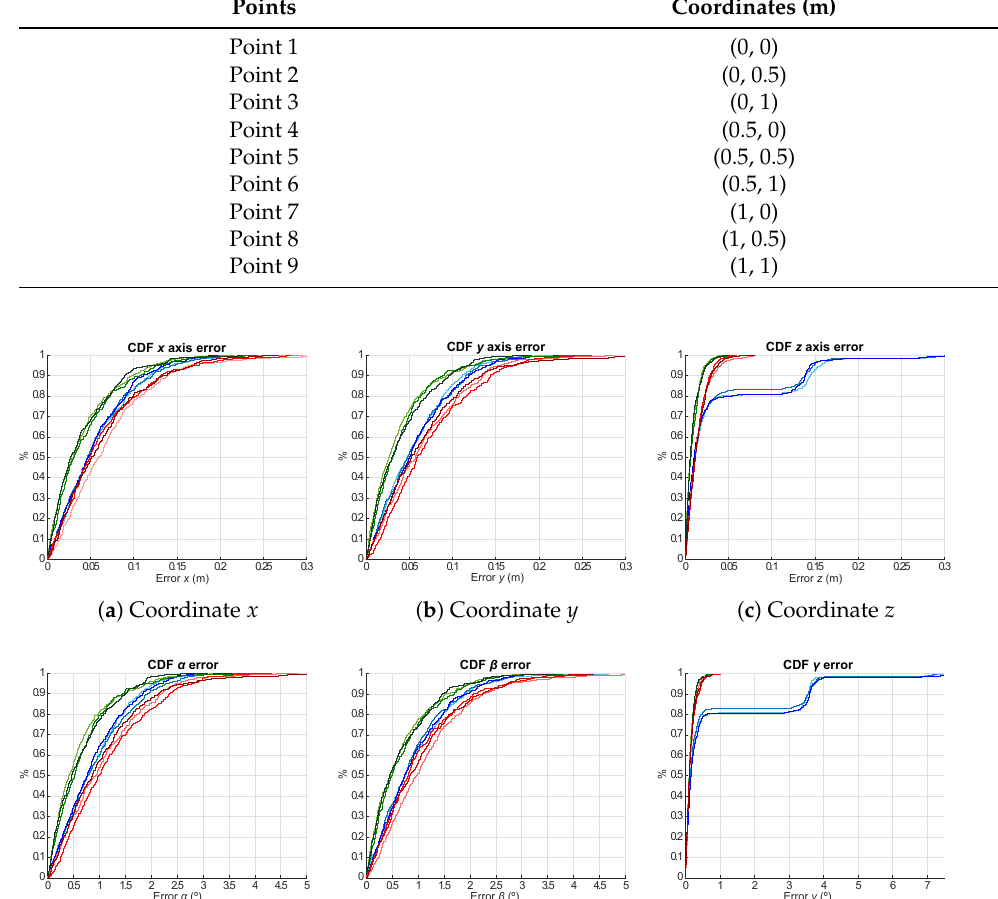
Table 1. Coordinates of the nine representative points considered in the first quadrant for further analysis.